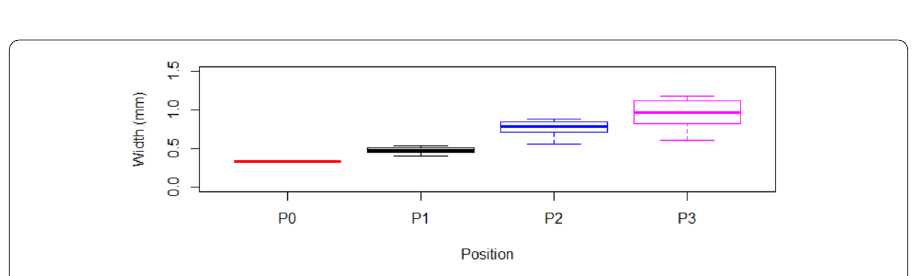
Figure 3 Tunnel widths in different positions